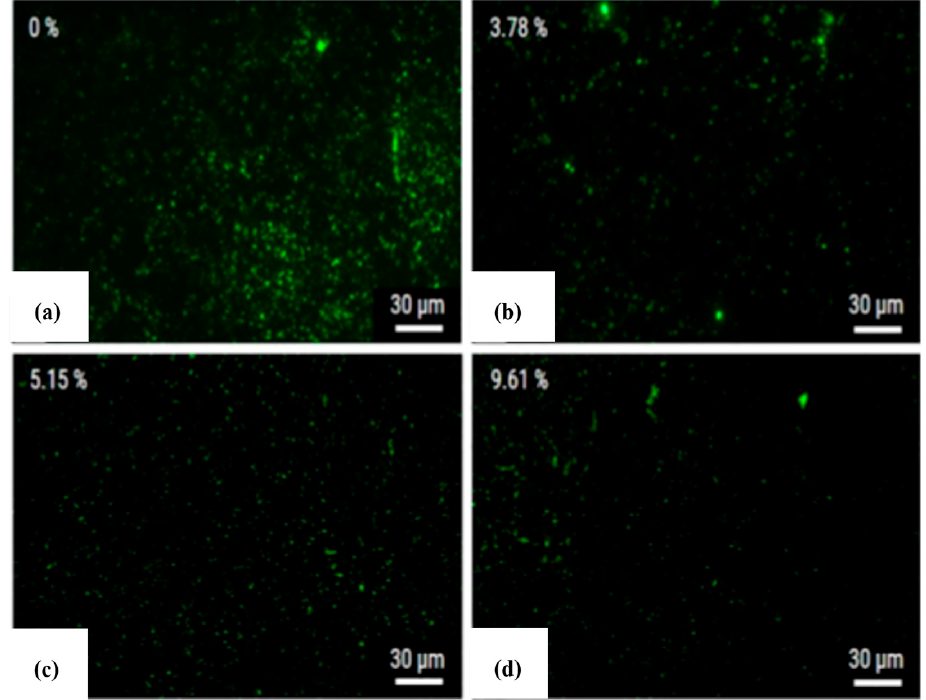
Figure 3. Amount of S. aureus bacteria on a Ti-6Al-4V surface, machined using ( a ) 0%, ( b ) 3.78%, ( c ) 5.15%, and ( d ) 9.61% silver on the dielectric fluid [39]. (With kind permission from Elsevier).